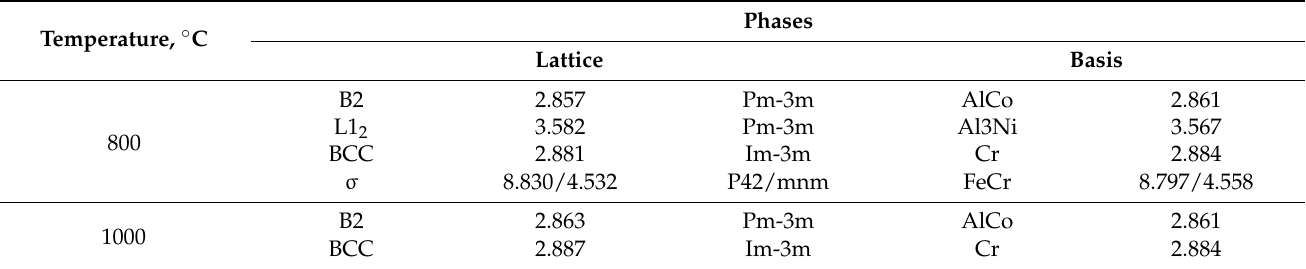
Table 4. Phase composition of bulk materials after CS + SPS and RSPS, depending on the temperature.